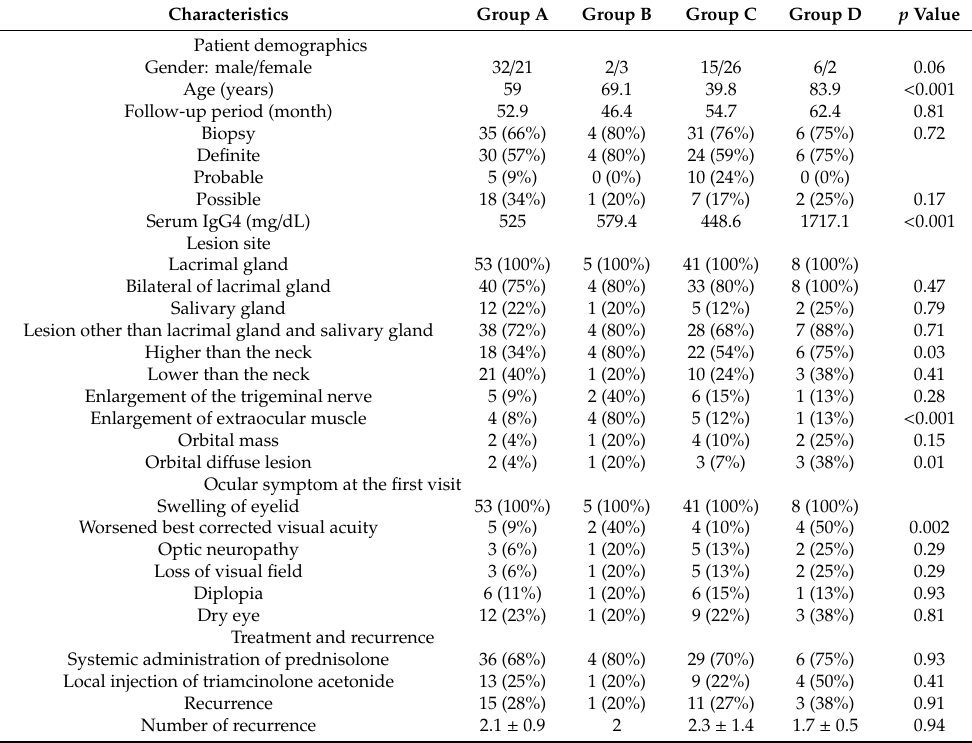
Table 3. Findings in the four groups classified according to clustering analysis.